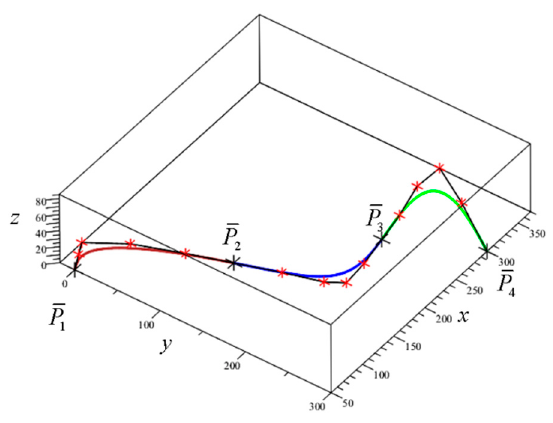
Figure 17. Fifth-degree Bézier spline curve of three segments.